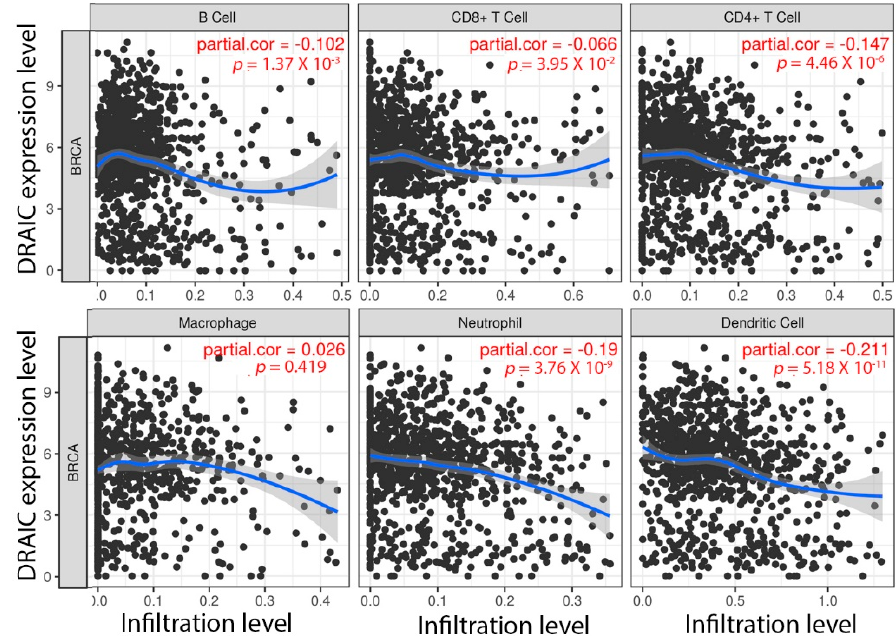
Figure 5. DRAIC expression negatively correlates with immune cell infiltration levels in breast cancer. The correlation between DRAIC expression and abundance of immune infiltrates is investigated through TIMER [27]. Correlation between DRAIC expression and the abundances of six immune infiltrates (B cells, CD4+ T cells, CD8+ T cells, Neutrophils, Macrophages, and Dendritic cells) are displayed. The purity-corrected partial Spearman correlation and statistical significance are shown on the top right corners.